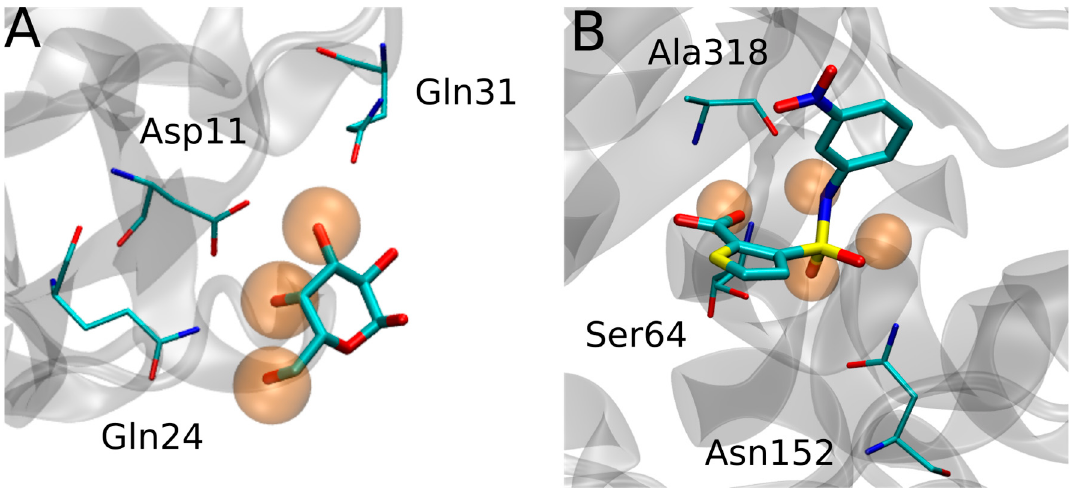
Figure 1. ( A ) Superposition of Sambucus nigra agglutinin II in complex with Lactose (PDB ID 3CA4) showing how the Water Sites (Orange transparent spheres) mimic the ligand -OH framework. ( B ) Escherichia coli AmpC beta-lactamase (PDB ID 1XGI) WS.